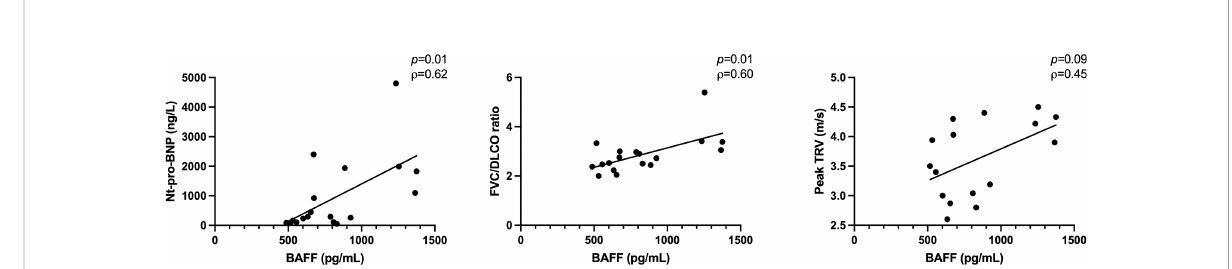
FIGURE 4 Associations between BAFF and clinical markers of PH, assessed among the 18 SSc-PAH patients from the validation cohort. BAFF, B-cell- activating factor; DLCO, diffusing capacity of the lung for carbon monoxide; FVC, forced vital capacity; Nt-pro-BNP, N-terminal prohormone of brain natriuretic peptide; PAH, pulmonary arterial hypertension; SSc, systemic sclerosis; TRV, tricuspid regurgitation velocity. Error bars display means and standard deviations. p -values are adjusted for